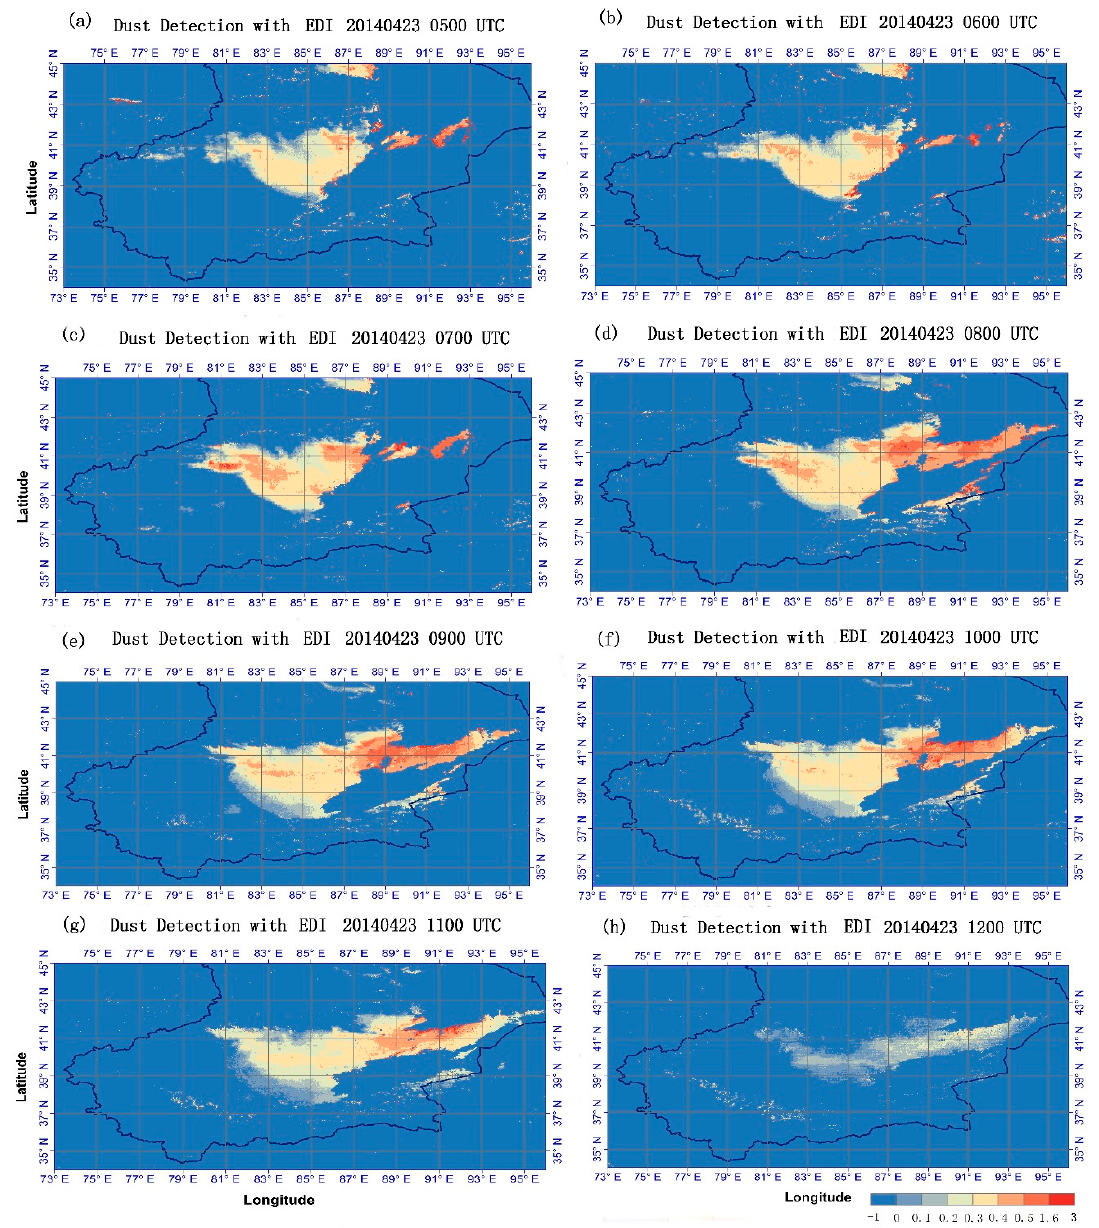
Figure 10. Enhanced Dust Index (EDI) images (from 5:00 UTC to 12:00 UTC) during a dust storm on 23 April 2014 (Non-dust pixels are assigned a value of − 1). ( a – h ) are the EDI values per hour from 5:00 UTC to 12:00 UTC, in 23 April 2014.